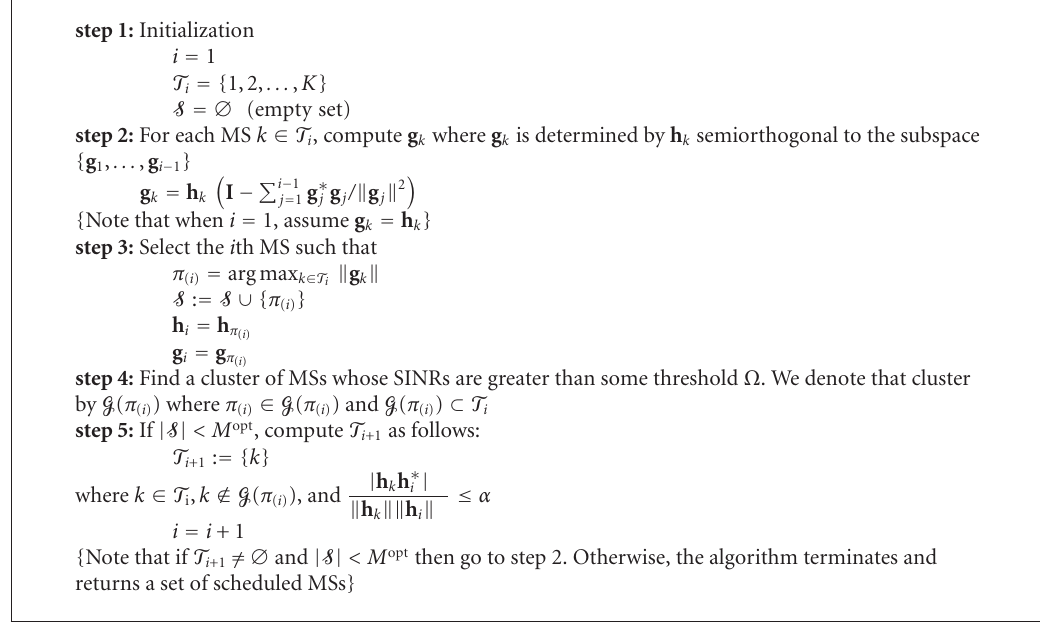
Algorithm 1: Greedy-selection-based